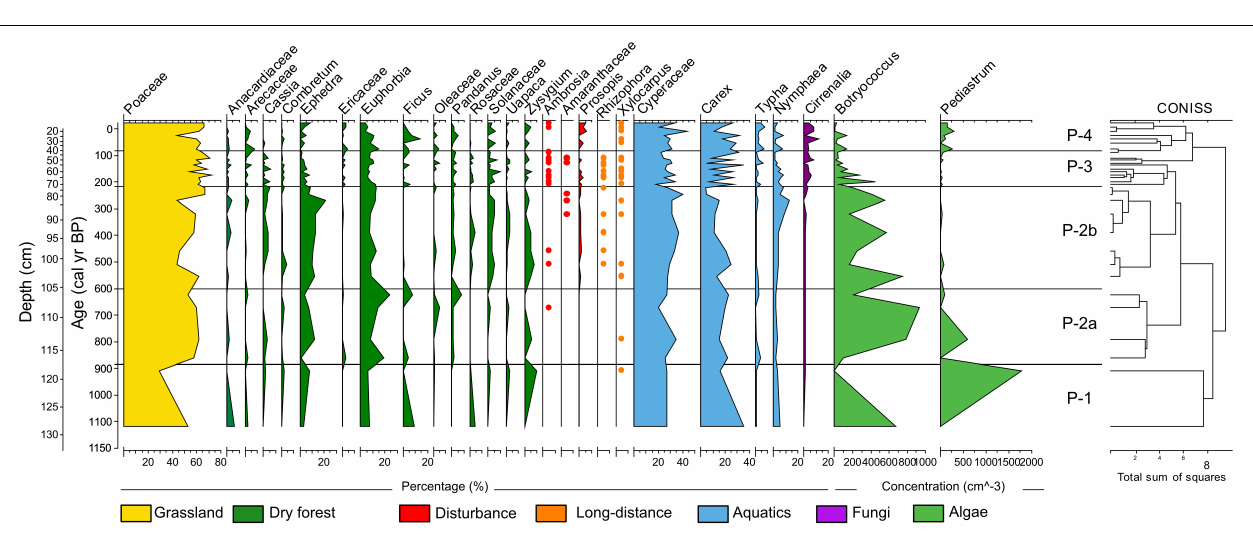
FIGURE 4 | Pollen relative abundance and algae concentration versus depth and calibrated radiocarbon age in the sediment core from Namonte, southwest Madagascar. CONISS analysis on the right side of the diagram shows the four major pollen zones, with zone P-2 divided into two